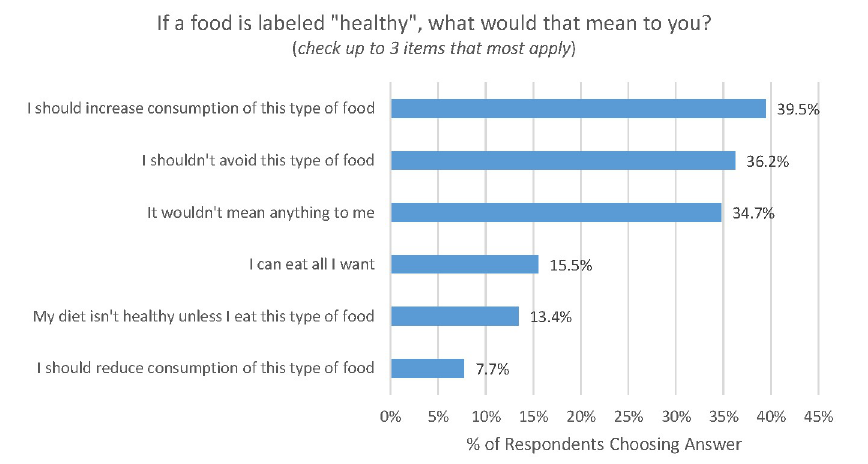
Fig 6. Behavioral implications of healthy food labels ( sampling error for each statistic is ±2 . 7% . ) .